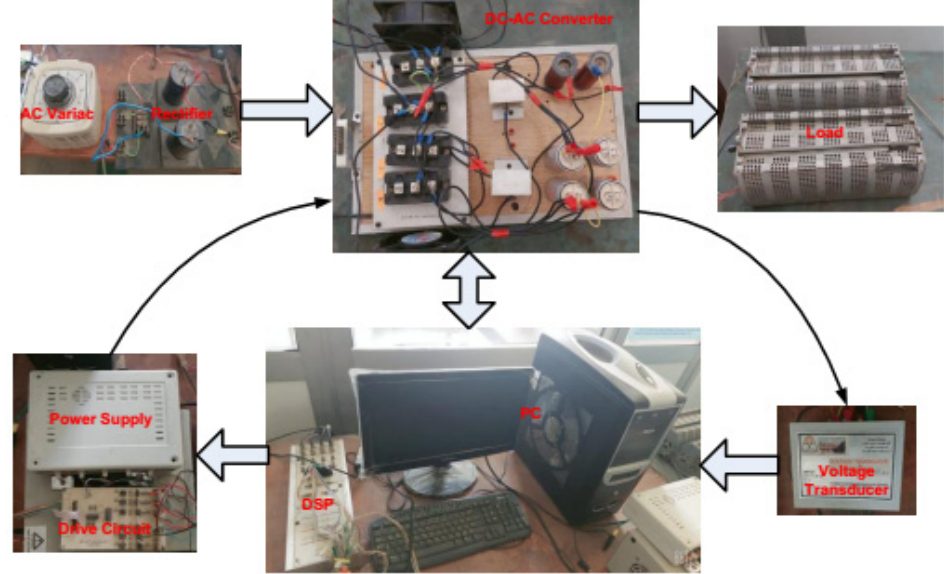
Figure 31. A Photograph of the Components Used in the Experimental Work.